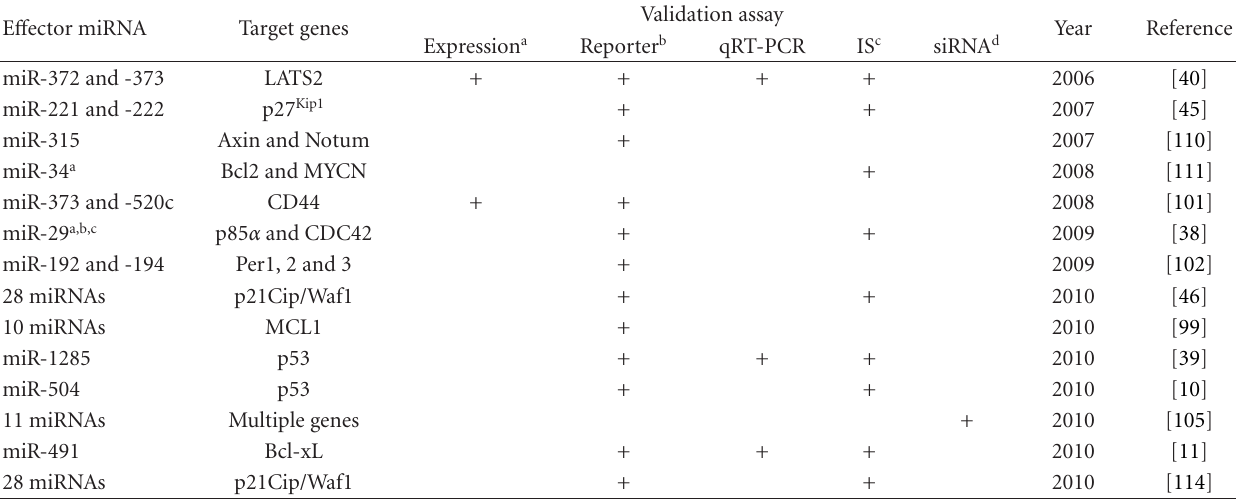
Table 3: Validation assays in miRNA-based